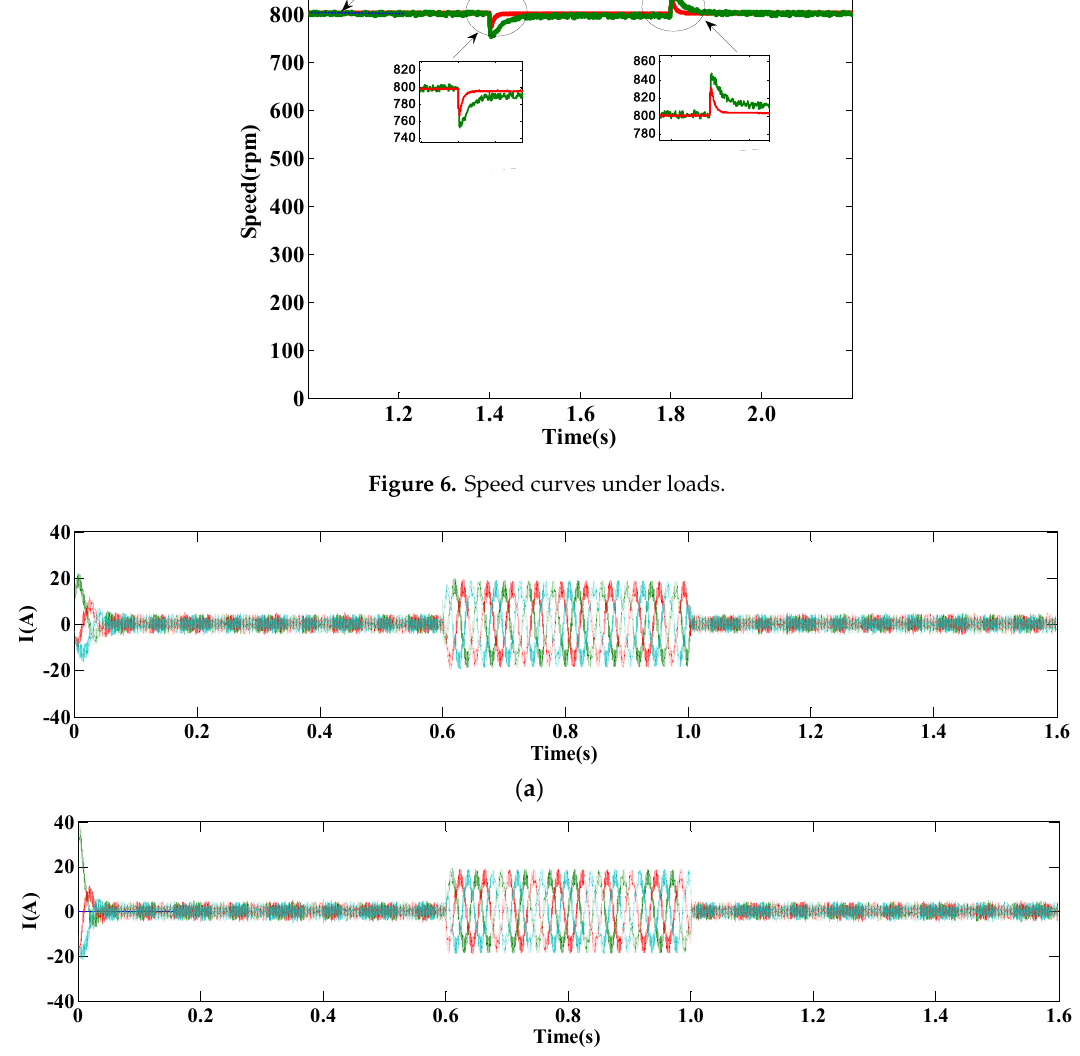
Figure 7. Three-phase current curve of PMIWM. ( a ) FTSMC, ( b ) sliding mode control (SMC). Table 3. Comparison of the speed responses by the FTSMC and SMC